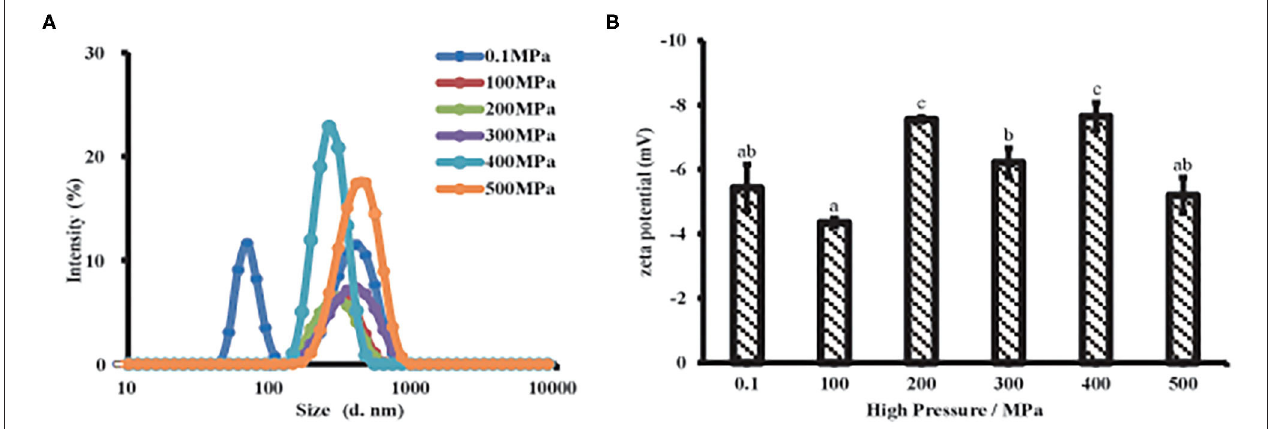
FIGURE 3 | Particle properties of MP solution from the scallop mantle under the UHP treatment. Particle size (A) and zeta potential (B)